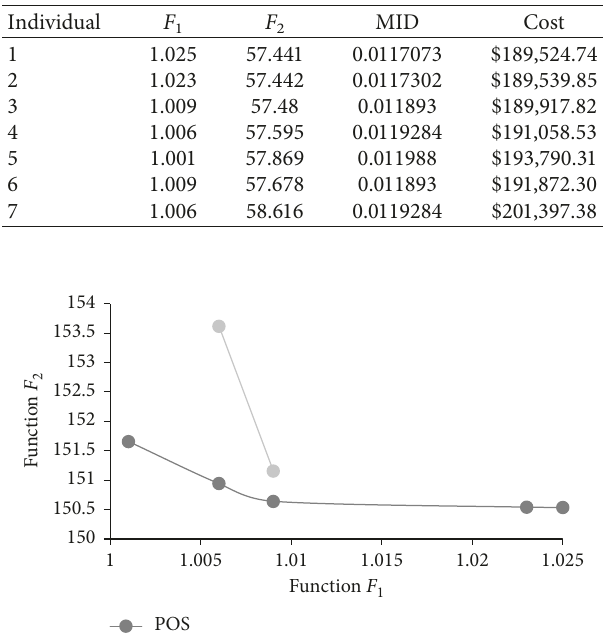
Figure 20: Optimal slab section selected from individual 1, model